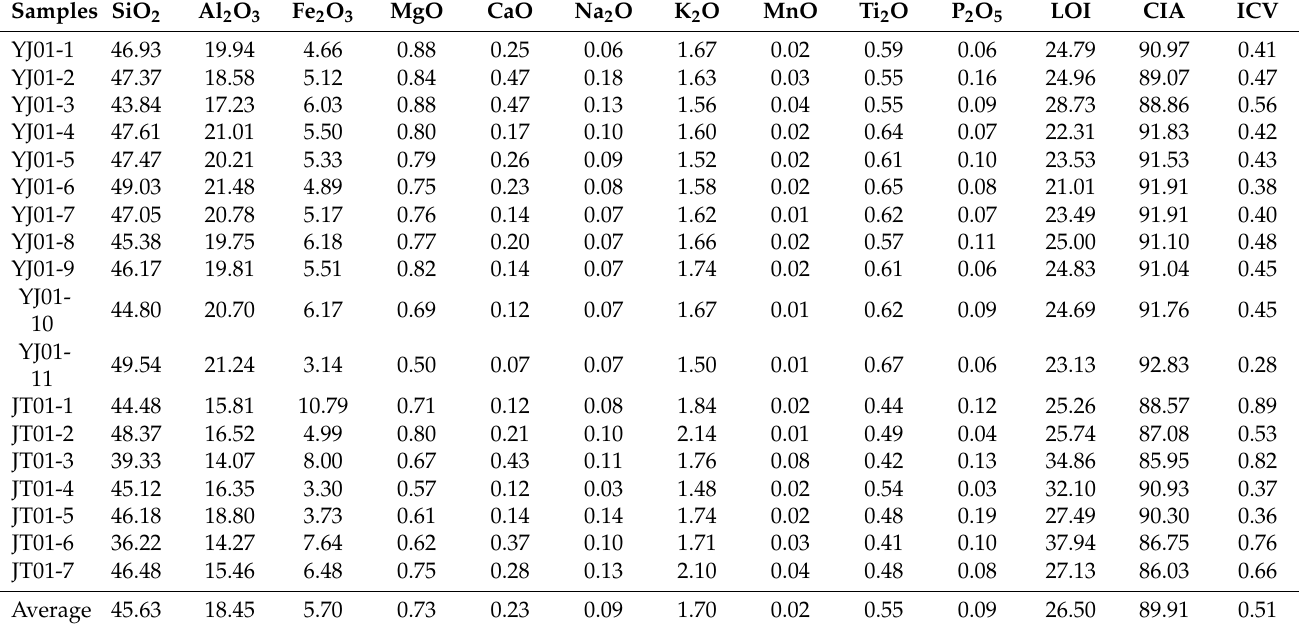
Table 2. Major elements (in wt.%) in oil shale of Youganwo Formation in Maoming